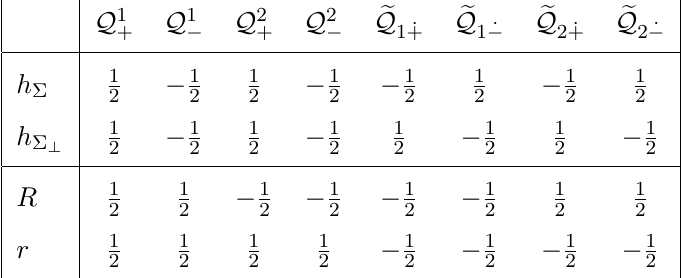
Table 1 . N = 2 supercharges and their quantum numbers. R and r denote the charges under U(1) R ⊂ SU(2) R and U(1) r respectively. See Equation (B.3) for our